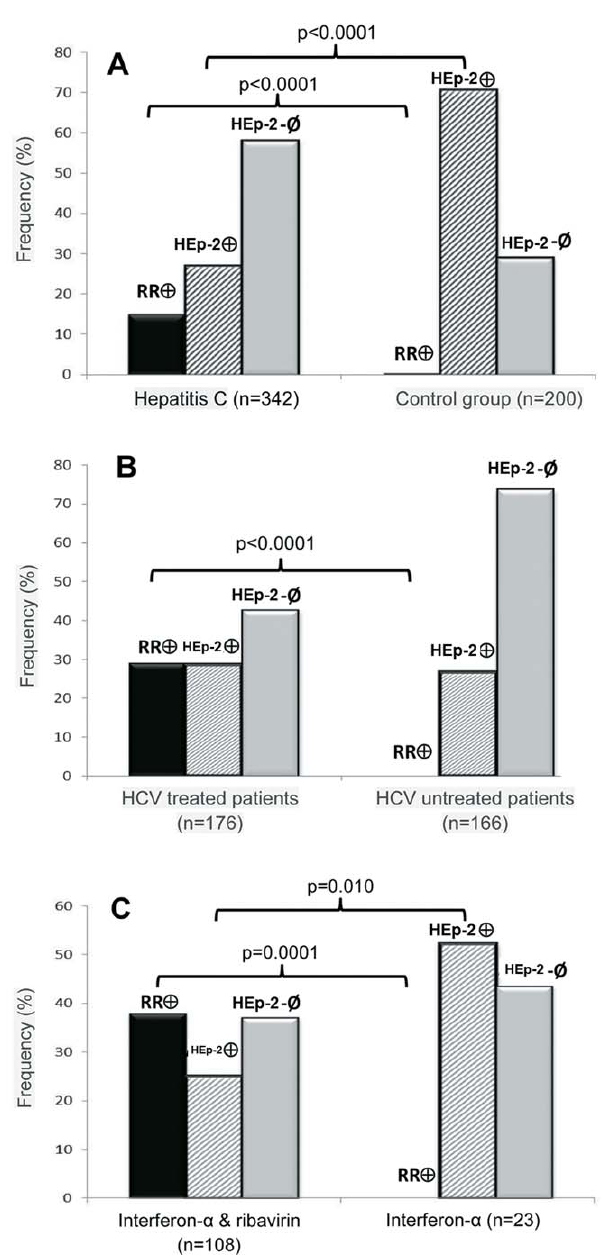
Figure 2. Antibodies to rods and rings are predominantly observed in HCV patients undergoing treatment with interfer- on- a plus ribavirin. Comparison of IIF-HEp-2 patterns in (A) Patients with HCV and the control group (systemic lupus erythematosus, systemic sclerosis, polymyositis, multiple sclerosis, hepatitis B, autoim- mune hepatitis); (B) Treated and untreated HCV patients; and (C) HCV patients treated with interferon- a plus ribavirin and those receiving only interferon- a . Black bars: Anti-RR-reactive; gray-lined bars: other IIF- HEp-2 patterns; gray solid bars: IIF-HEp-2-negative.